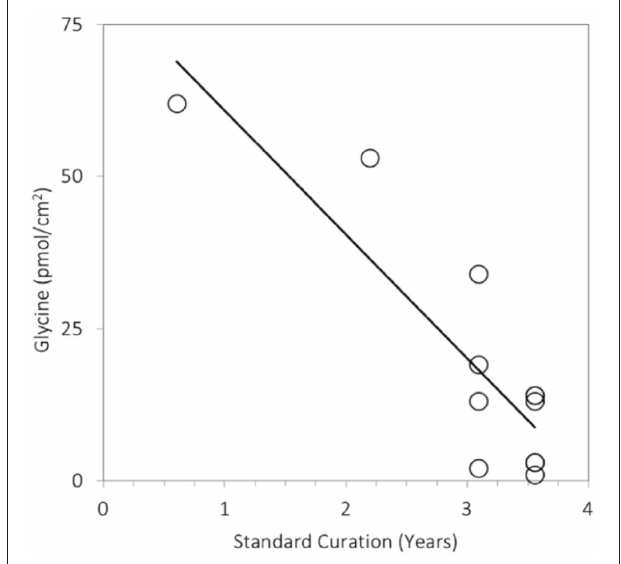
FIGURE 6 | Steady decline in the abundance of the amino acid glycine extracted from Stardust foils exposed to comet Wild 2 as a function of time in curation. The foils were stored at room temperature in an ISO Class 5 cleanroom at NASA’s Johnson Space Center. Measurements were obtained using the methods described in Glavin et al. (2008) and Elsila et al.